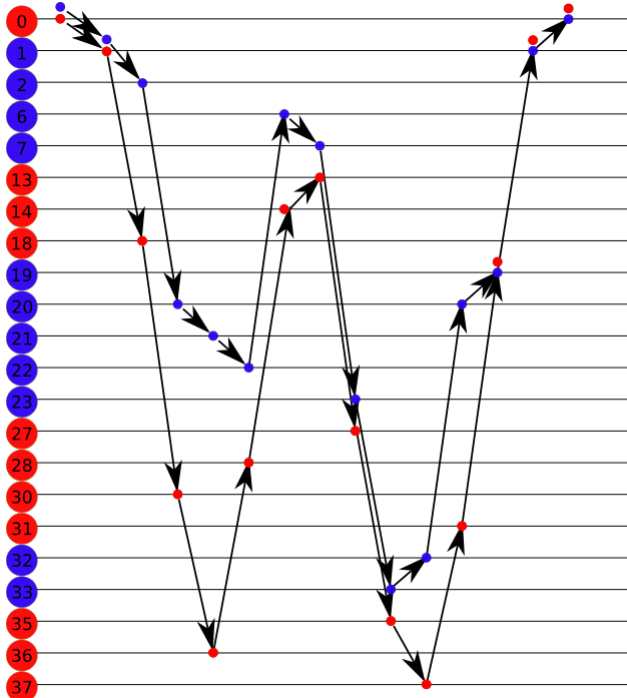
Figure A2. The operational environment as a causal graph. Some regions are visited by multiple MDFs when there is only one